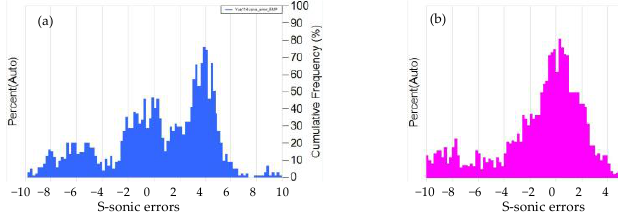
Figure 18. Statistical histogram of S-sonic errors predicted by different methods: ( a ) Empirical formula, ( b ) Rock physics modeling, ( c ) Deep learning.